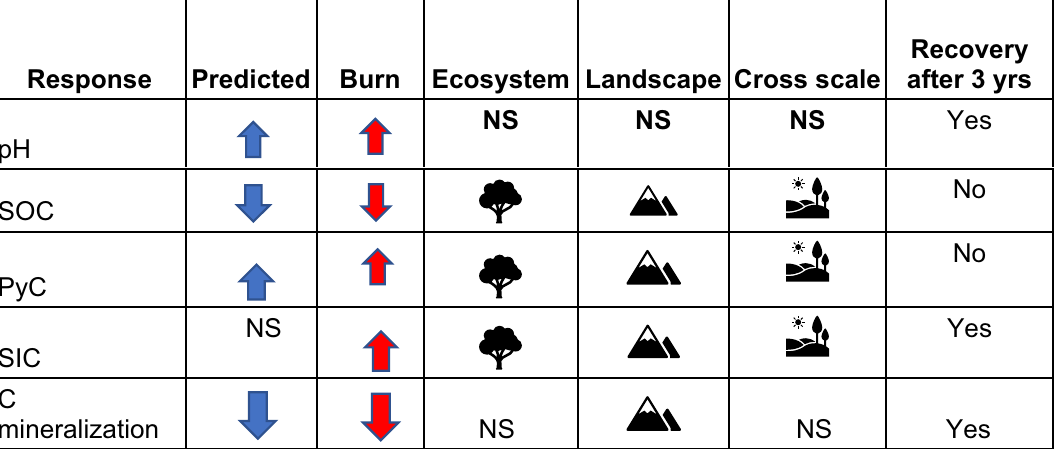
Figure 6. Cross-scale responses to fire were observed. Observed main burn response compared to predicted response based on disturbance theory and Fellows et al. 24 in the case of C mineralization. We found ecosystem and landscape scale dependent responses and interactions across different scales. Recovery after 3-year post-fire (yes or no) is reported showing that recovery varies with soil property and